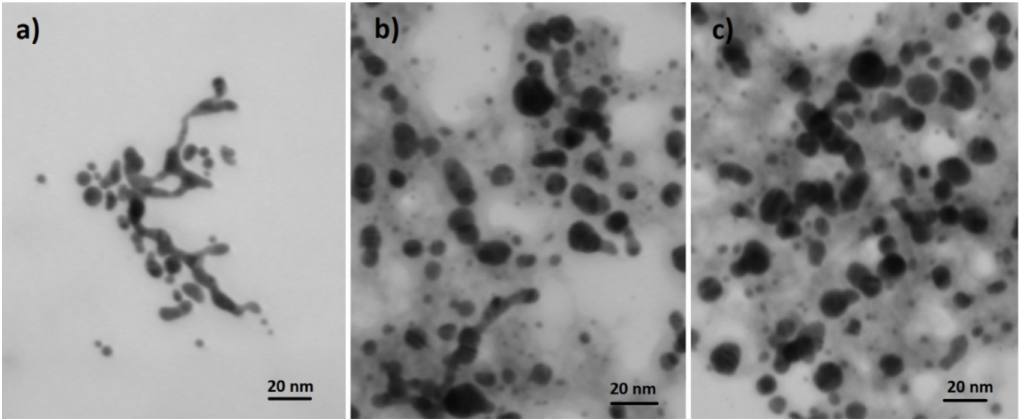
Figure 1. STEM image of the alloy (50:50): ( a ) Au-Ag NPs, ( b ) and ( c ) (Au-Ag)@LCC. As seen from the histogram (Figure 2) the size of the rounded nanoparticles is about 8 nm and tails down to 2 nm and up to 13 nm.